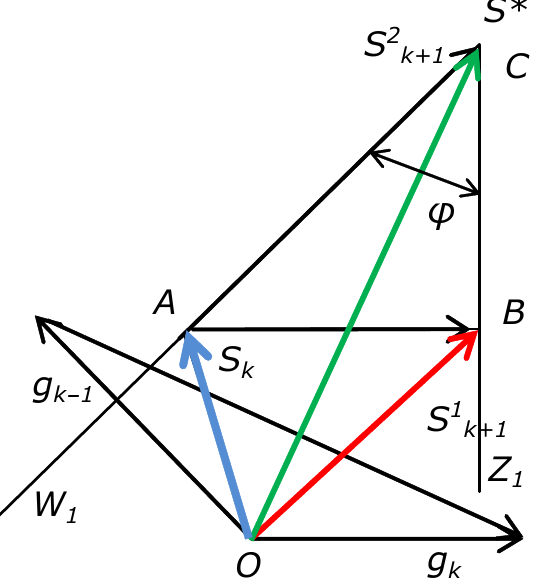
Figure 2. Projections of approximations s k + 1 in the plane of vectors g k , g k − 1